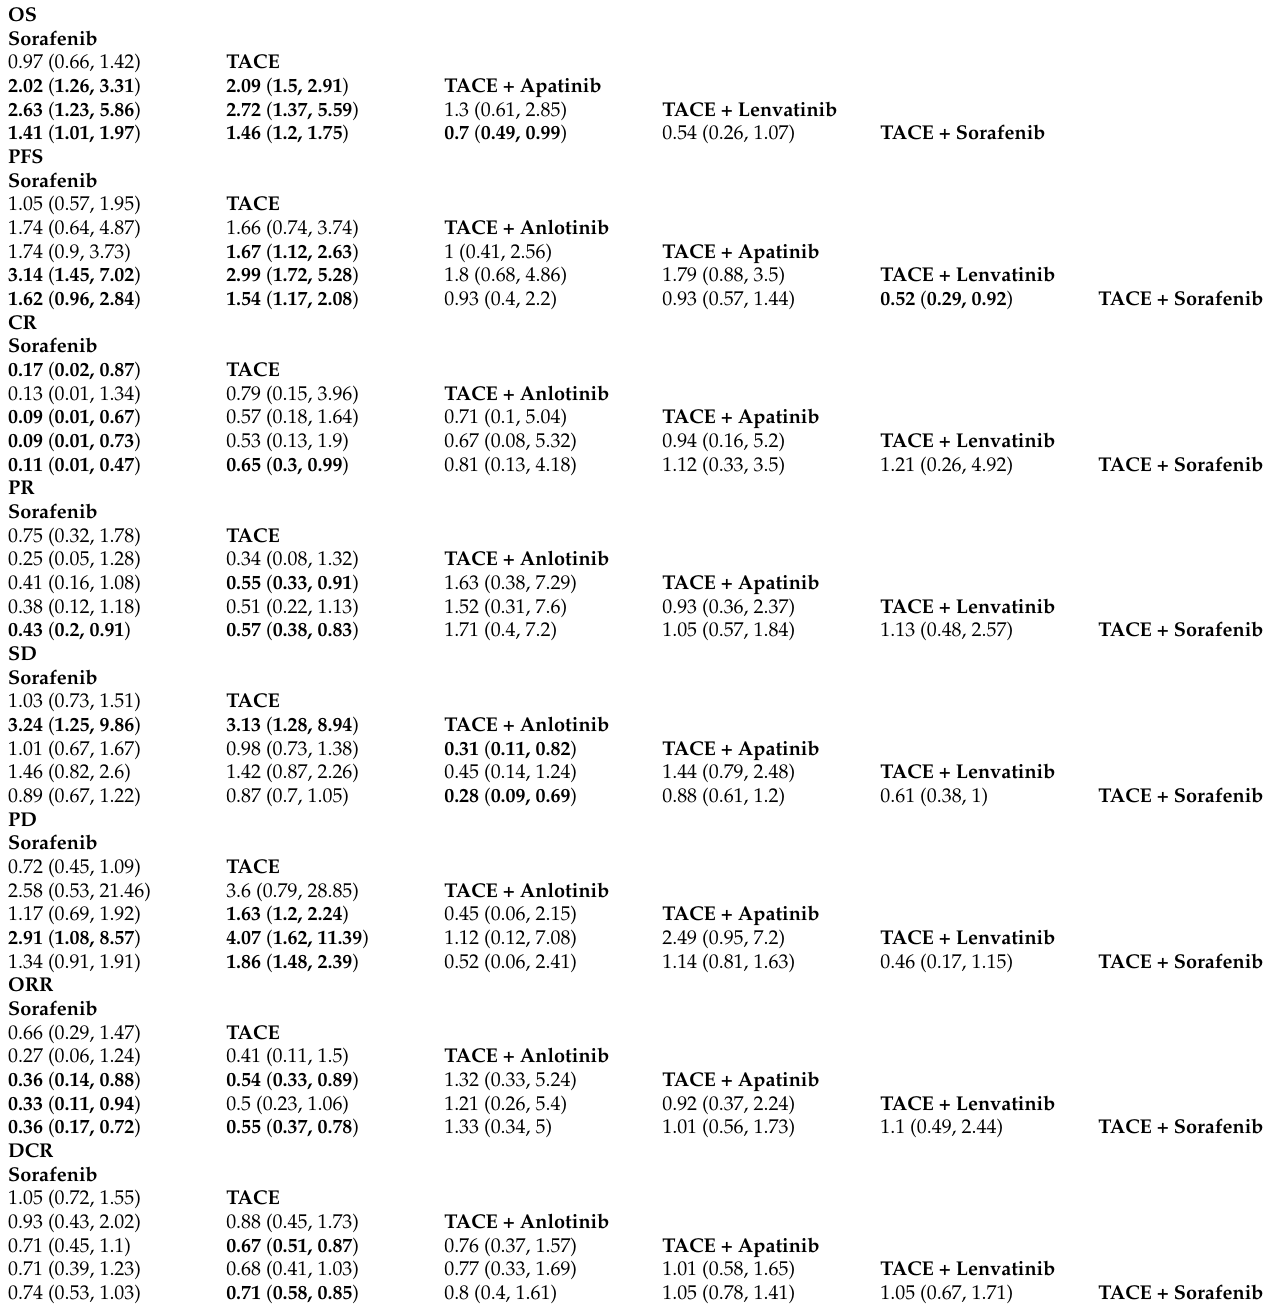
Table 1. League table showing indirect comparisons among TACE plus TKI